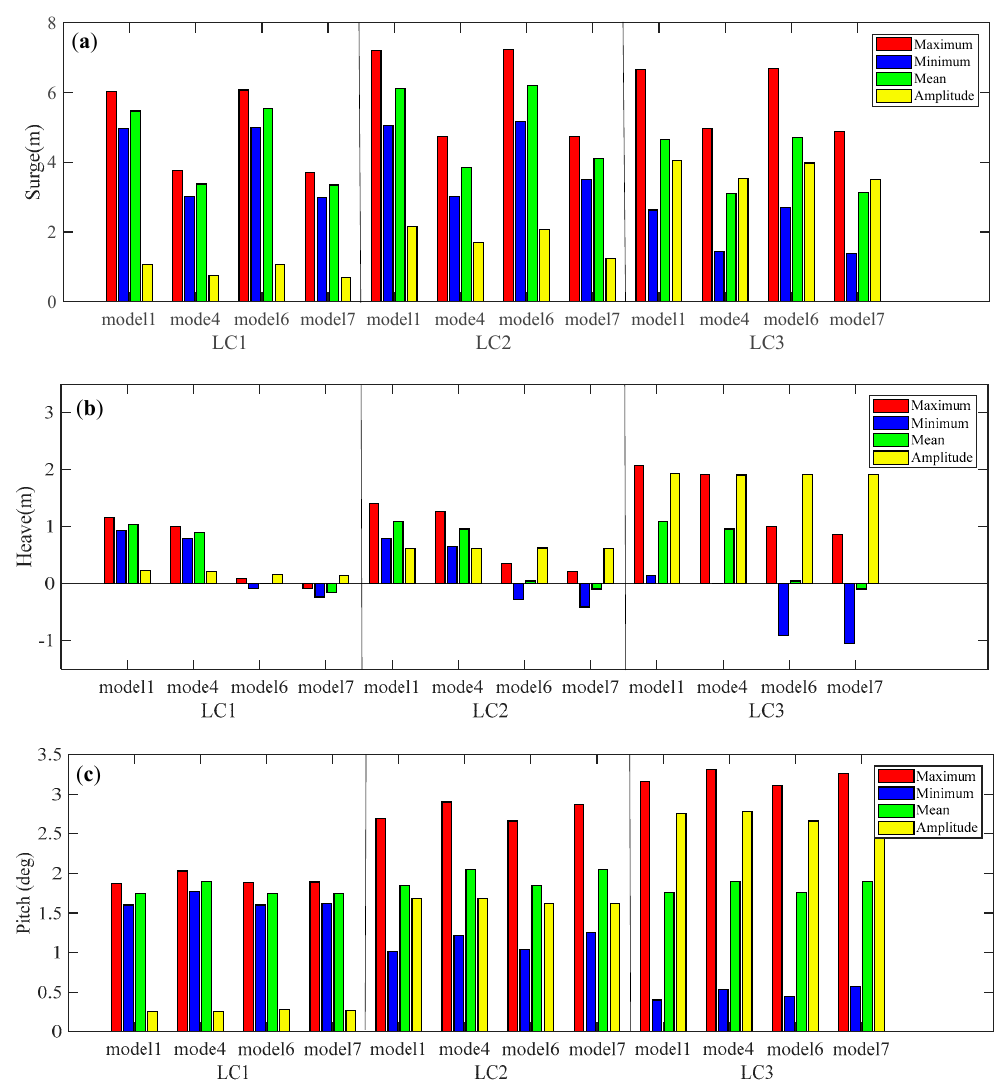
Figure 23. Comparison of the statistics of the stationary motion of Model 1, 4, 6, and 7 from 400–600 s: ( a ) surge; ( b ) heave; and ( c ) pitch.